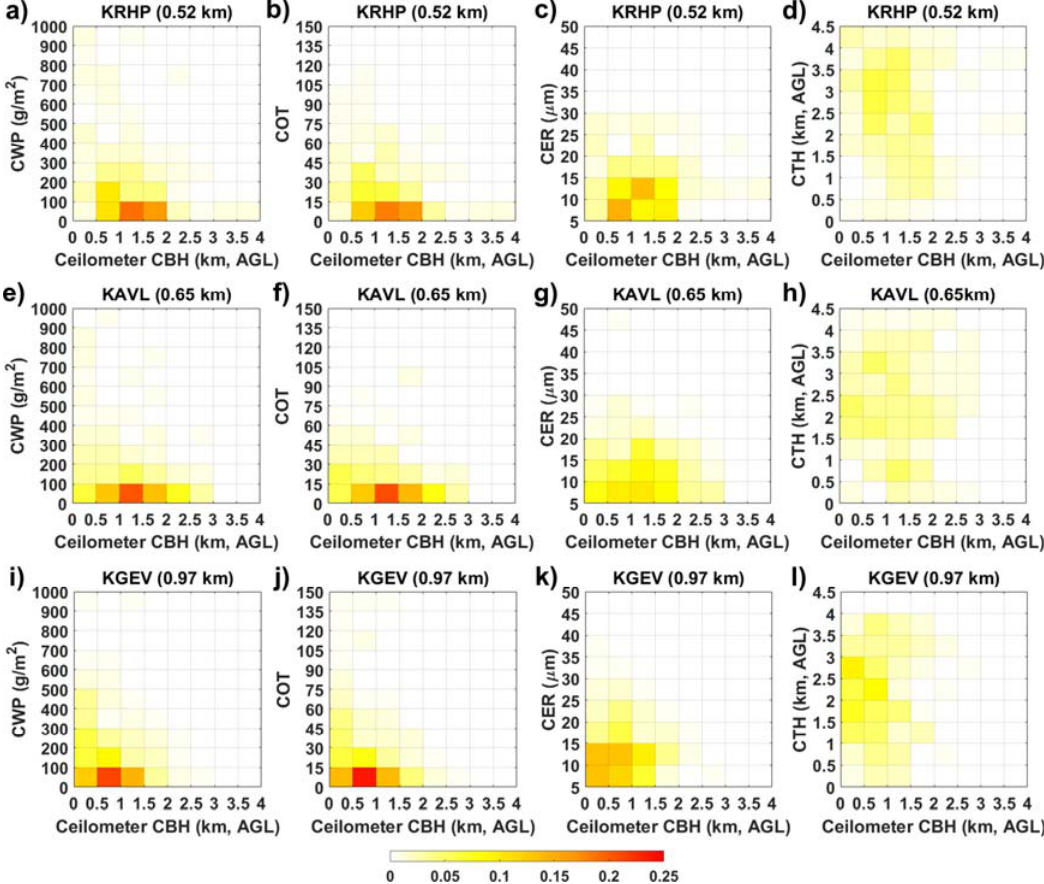
Figure 15. Fractional occurrences of collocated MODIS cloud properties of LLCF (single-layer clouds with CTH < 5 km MSL) as a function of ceilometer CBHs at KRHP ( a – d ), KAVL ( e – h ), and KGEV ( i – l ) during June 2006–October 2016 (daytime overpasses only). Note the elevation of each site is denoted in parentheses after its name. In each panel, CWP represents cloud water path, COT represents cloud optical thickness, and CER represents cloud particle effective radius.